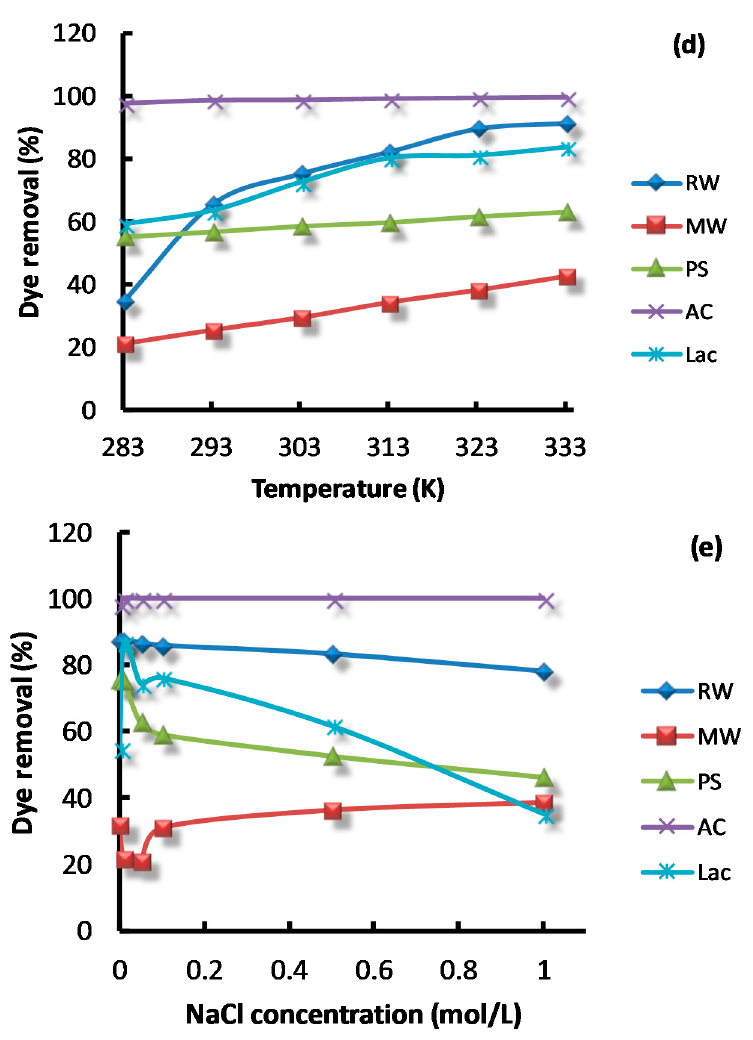
Figure 3. Dye removal under various conditions: adsorbent dose or laccase activity ( a ); contact time ( b ); dye concentration ( c ); temperature ( d ); NaCl concentration ( e ).